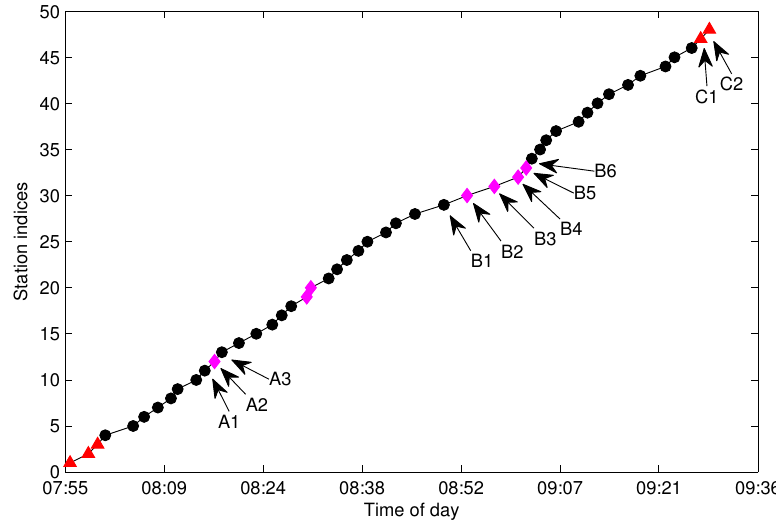
Figure 9. The illustration of different types of missing